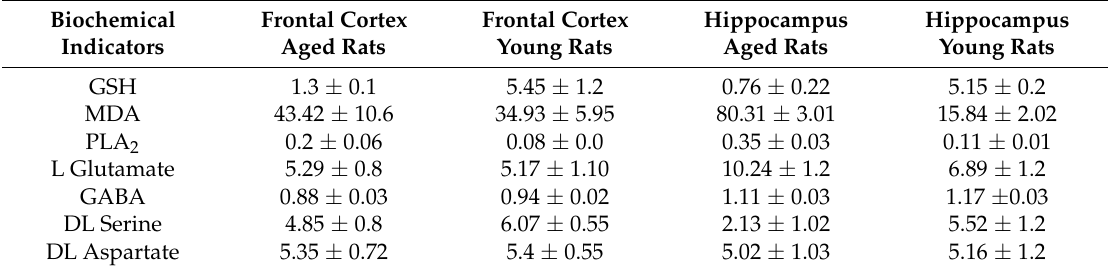
Figure 4. Effect of aging on amino acid concentration in the examined brain areas. ( A ) L Glutamate, ( B ) DL Serine, ( C ) GABA, ( D ) DL Aspartate. *** ( p < 0.001); * ( p < 0.05) corresponds to significant differences between experimental groups. 4. Discussion